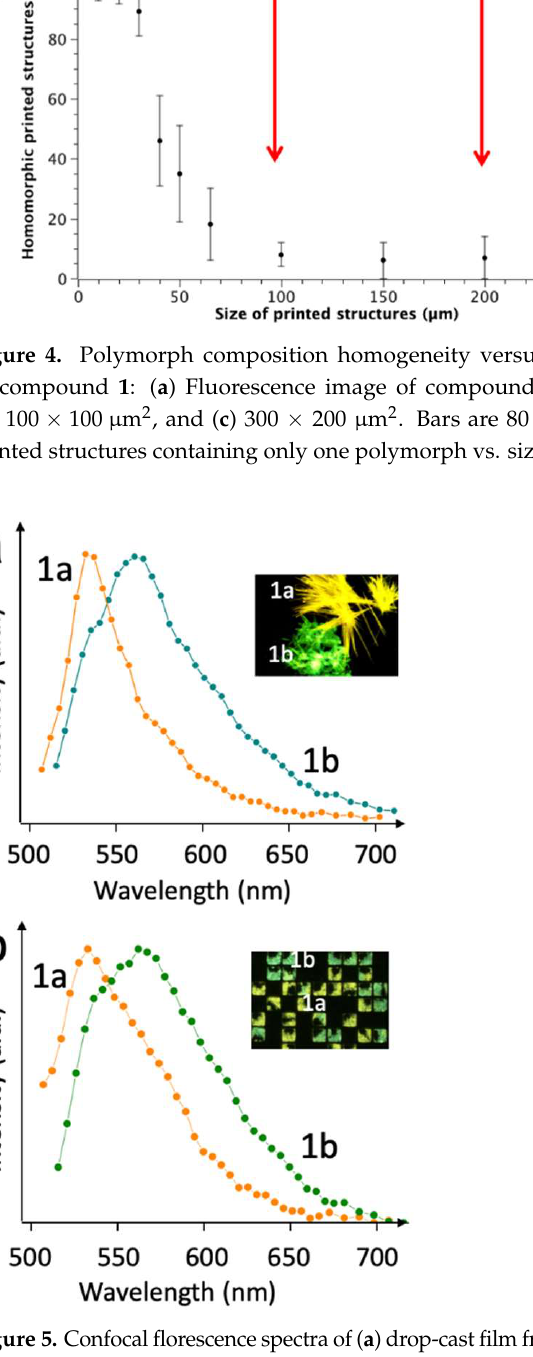
Figure 5. Confocal florescence spectra of ( a ) drop-cast film from toluene solution on silicon; ( b ) Patterned structures of a 20 × 20 µ m 2 size. 1a and 1b refer to the different polymorphs of compound 1 . Noticeably, the total percentage of the two polymorphs, obtained by counting the printed structures, is almost the same as that obtained in the in drop-cast film. Moreover, in the